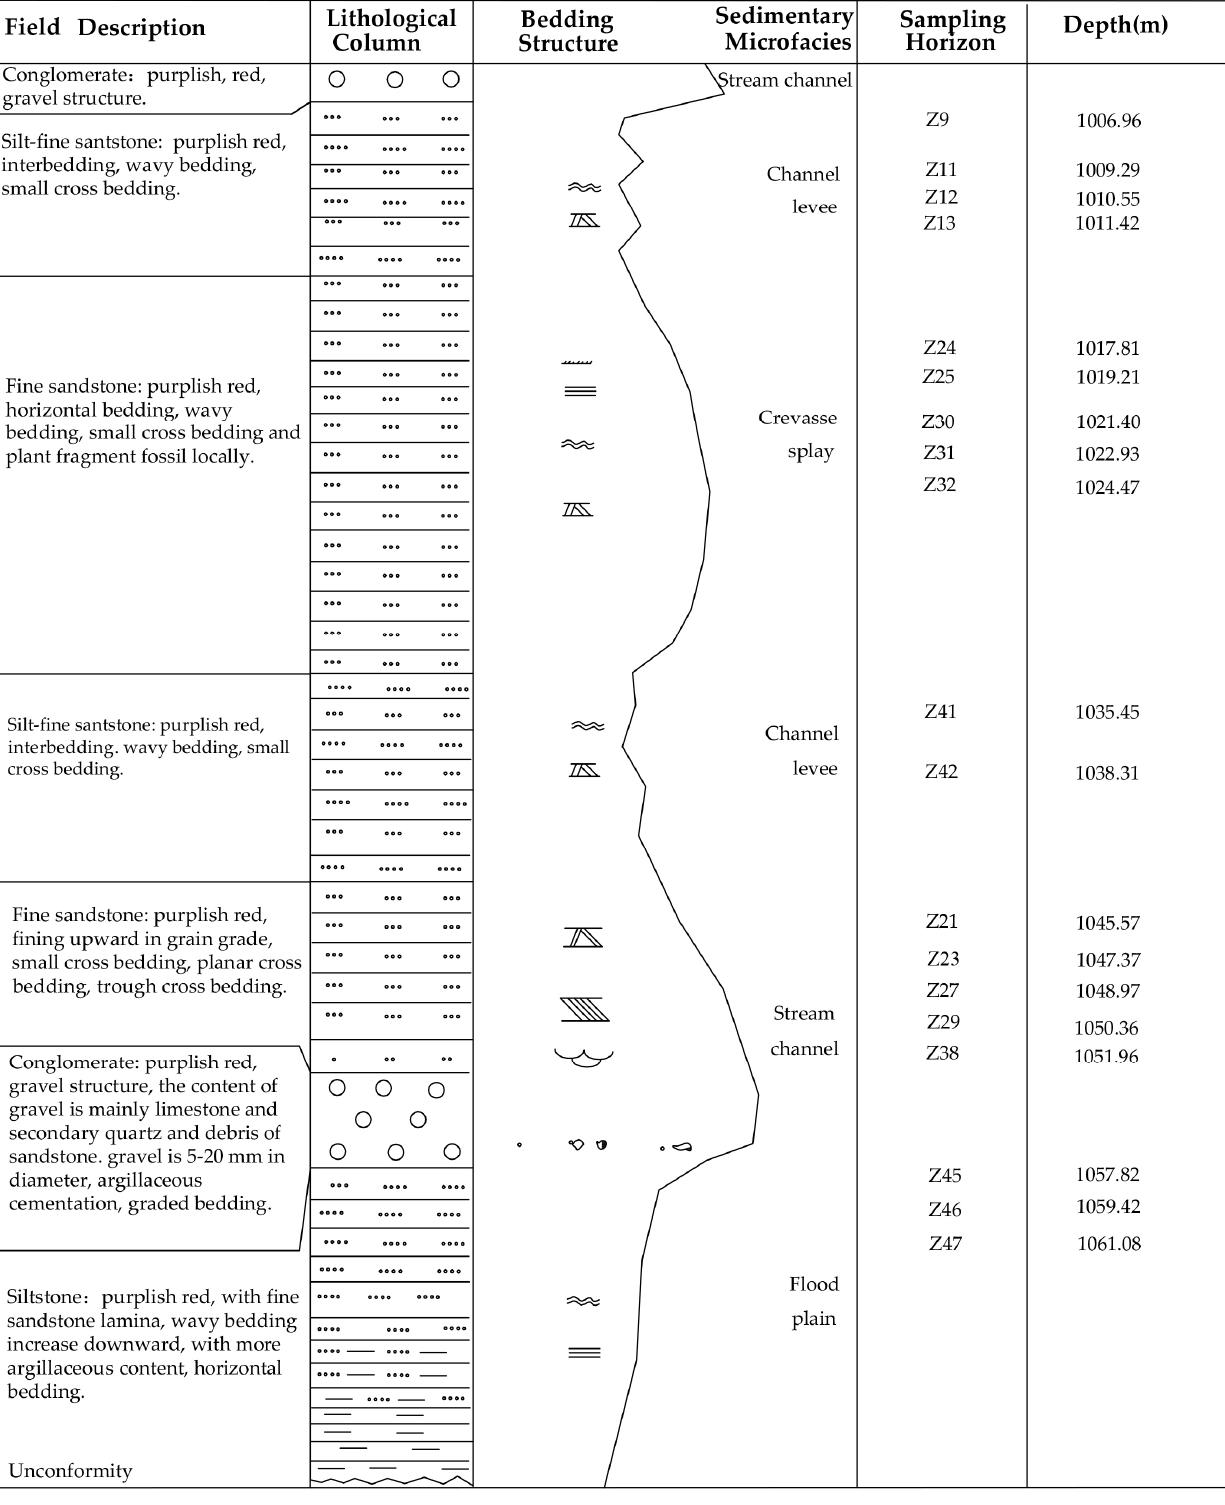
Figure A3. The sampling horizon and depth of the Jurassic sandstone in borehole J3-1 of No. 6 mining area of the Anju coal mine, the Southwest Shandong coalfield, China.